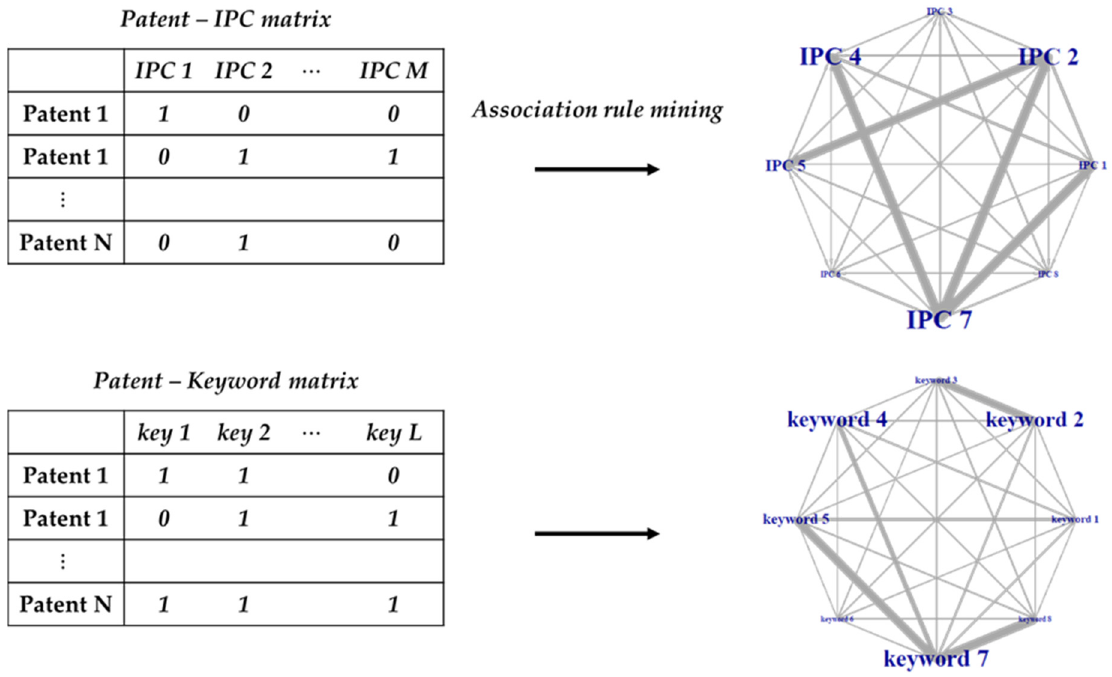
Figure 4. Investigation into emerging and vacant technology